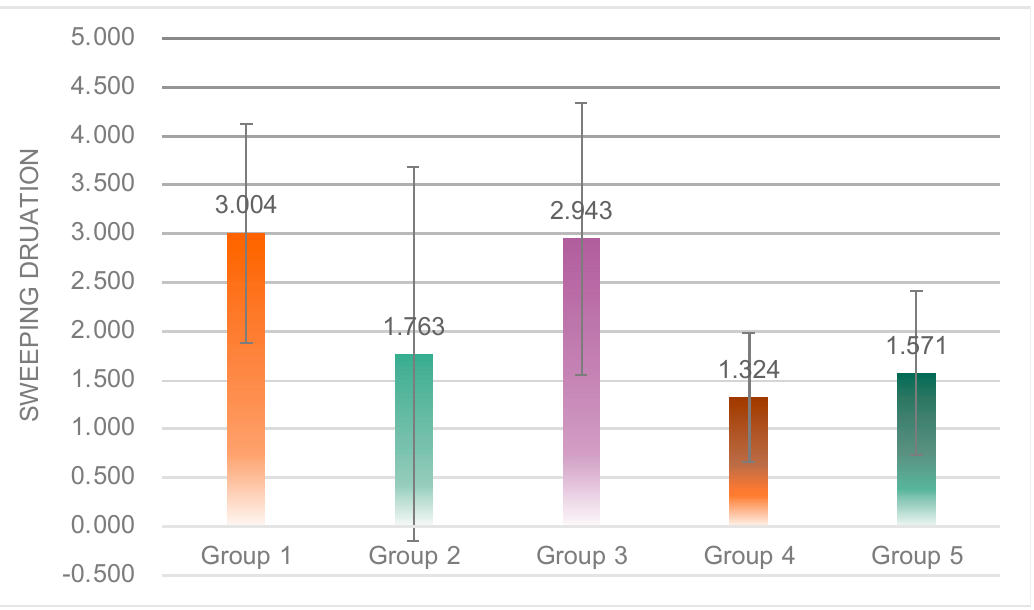
Figure 18. Individual differences in the total sweep duration of the five groups.